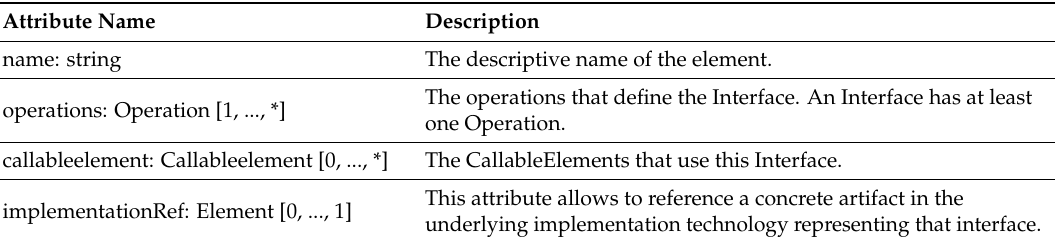
Table 1. Interface attributes and model associations.